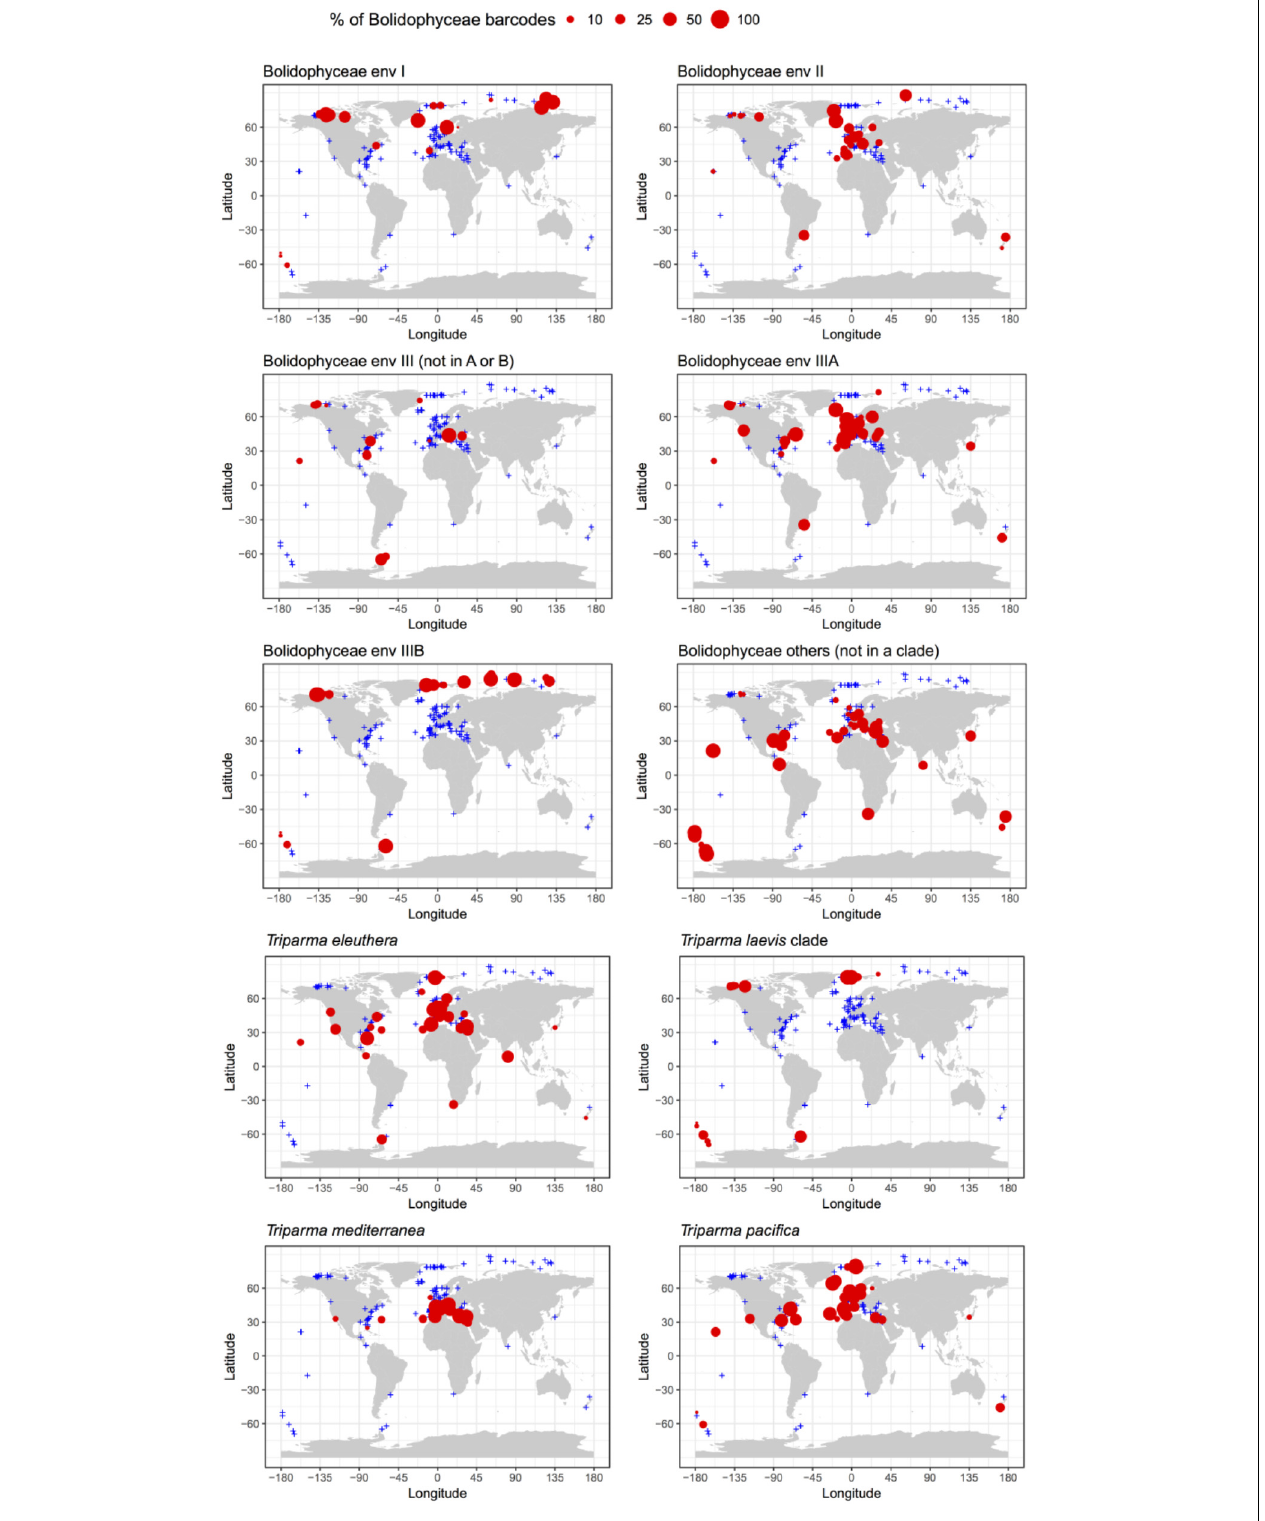
FIGURE 7 | Percentage relative to the total number of Bolidophyceae reads of the different environmental Bolidophyceae clades and Triparma species in the metabarcoding studies based on the 18S rRNA V4 region listed in Table 2 . Only surface samples were considered.